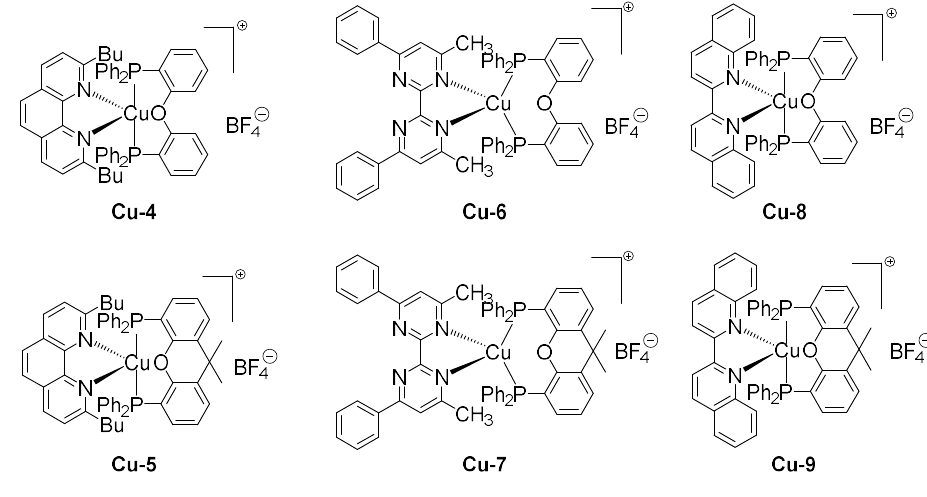
Figure 7. Chemical structures of Cu-4 – Cu-9 . Table 1. TMPTA conversions determined in laminate for two-component systems Cu-x(x = 4–6)/ Iod (0.2%/2% w / w ) upon irradiation at different wavelengths for 500 s and light absorption properties at the emission wavelengths of the different light sources (extracted from the work in [80]).